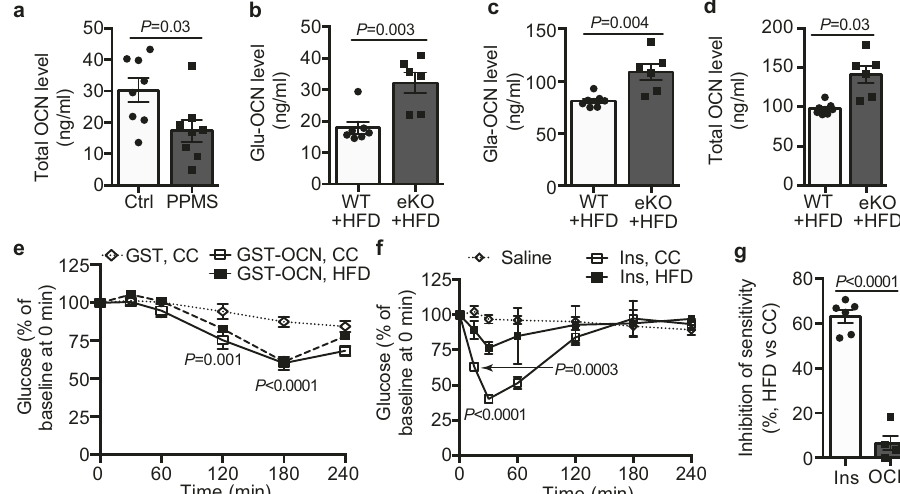
Fig. 6 OCN, induced by LRP1 depletion in HFD-fed mice, promotes blood glucose clearance. a Blood OCN levels in human metabolic syndrome patients (MS) and normal lean controls (Ctrl). b – d Blood Glu-, Gla- and total OCN levels in HFD-fed WT and eKO mice. Results for control chow (CC)-fed mice are included in Fig. 1d. e – g OCN and insulin tolerance tests in CC and HFD mice (OTTs in e , ITT in f ). The inhibition of maximal sensitivity for insulin and OCN in HFD-fed mice compared to CC-fed ones is presented in g . n = 11 ( a ), 7 ( b – d , WT), 6 ( b – d , eKO), 5 ( e ; f , saline; g , OCN), 4 ( f , insulin, CC), 6 ( f , insulin, HFD; g , insulin). Data are presented as mean ± SEM. Analysis was unpaired two-tailed Student ’ s t -test ( a – d, g ) or two-way ANOVA followed by Fisher ’ s LSD multiple comparison test ( e , f